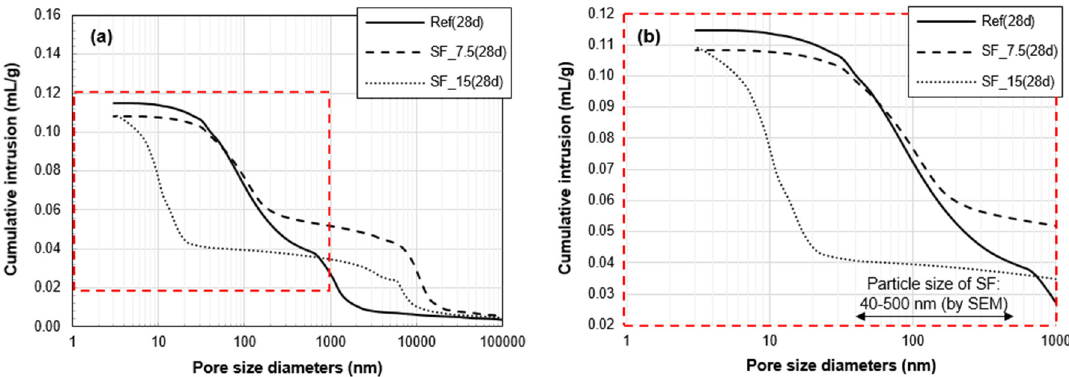
Figure 6. Cumulative pore volume ( a ), and classification of pozzolanic and filling effects ( b ) at 28 days.